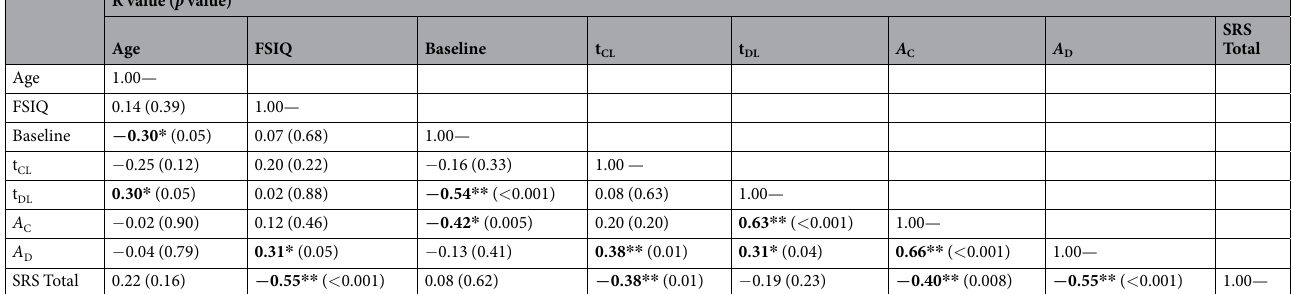
Table 1. Correlation matrix including pupil metrics, age (in years), FSIQ, and SRS Total T-score. Note: * Indicates correlation is significant at the 0.05 level (two-tailed); ** indicates correlation is significant at the 0.01 level (two-tailed). Abbreviations: Baseline = baseline pupil diameter; t LC = latency to constrict; t LD = latency to dilate; A C = amplitude of constriction; A D = amplitude of dilation.